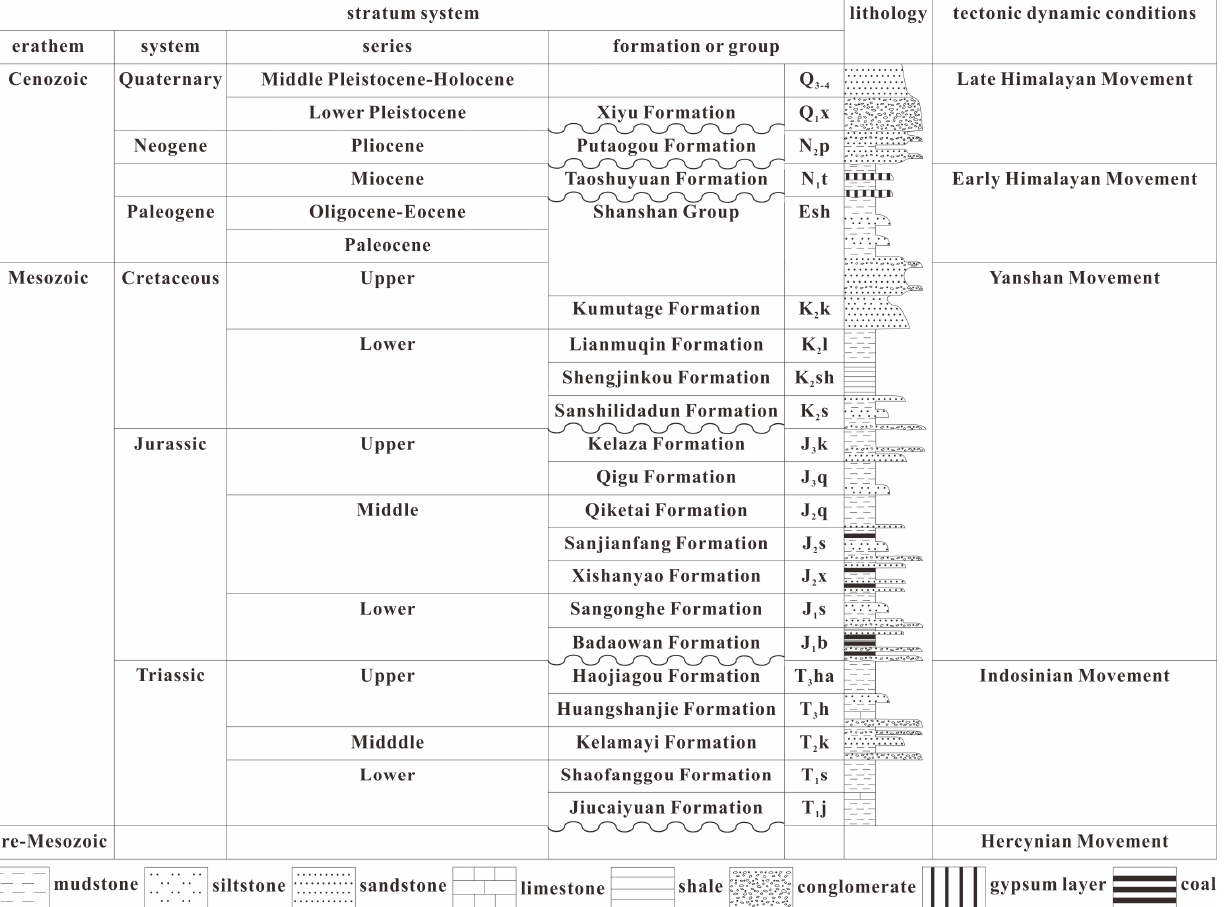
Figure 3. Geological cross-section showing the structural style and the morphology pattern of stratigraphic units of the FTB in the Turpan Basin (modified from Nishidai and Berry [92], Fu et al. [60], location of A–A ′ in Figure 1c), T: Triassic unis, J 1 : Lower Jurassic units, J 2 : Middle Jurassic units, J 3 : Upper Jurassic units, K: Cretaceous units, E: Paleogene units, N 1 : Miocene units, N 2 : Pliocene units, Q: Quaternary units, see text for details.